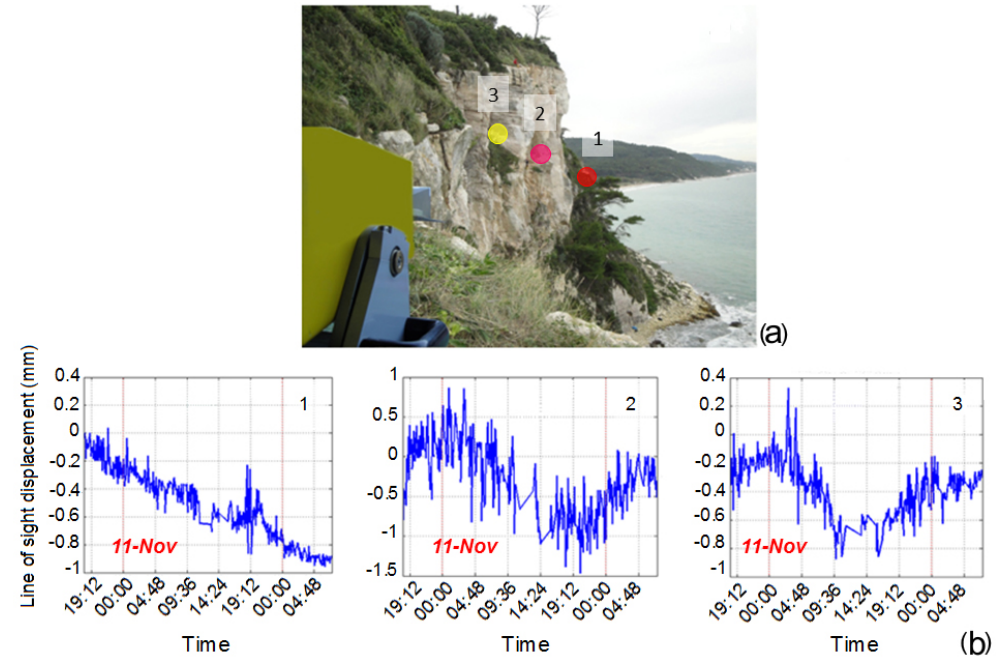
Fig. 9. (a) picture showing the GBInSAR interferometer installed in the east of the Mt. Pucci cliff slope; (b) time series of displacements of three points located on the cliff (colored circles identify the corresponding point locations on the cliff slope). Coordinates of the three points (Lat and Long in WGS84 and Elevation in ma.s.l.): (1) Lat 15 ◦ 59 0 22.75 00 , Long 41 ◦ 56 0 44.28 00 , Elevation 25.3; (2) Lat 15 ◦ 59 0 25.59 00 , Long 41 ◦ 564 0 45.33 00 , Elevation 46.9; (3) Lat 15 ◦ 59 0 26.25 00 , Long 41 ◦ 56 0 45.50 00 , Elevation